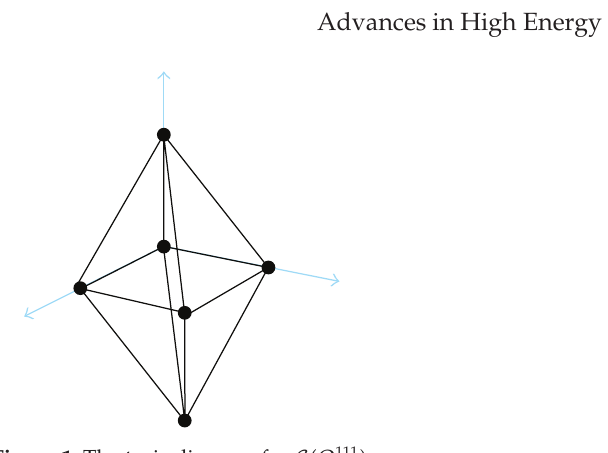
Figure 1: The toric diagram for C (cid:4) Q 111 (cid:5)